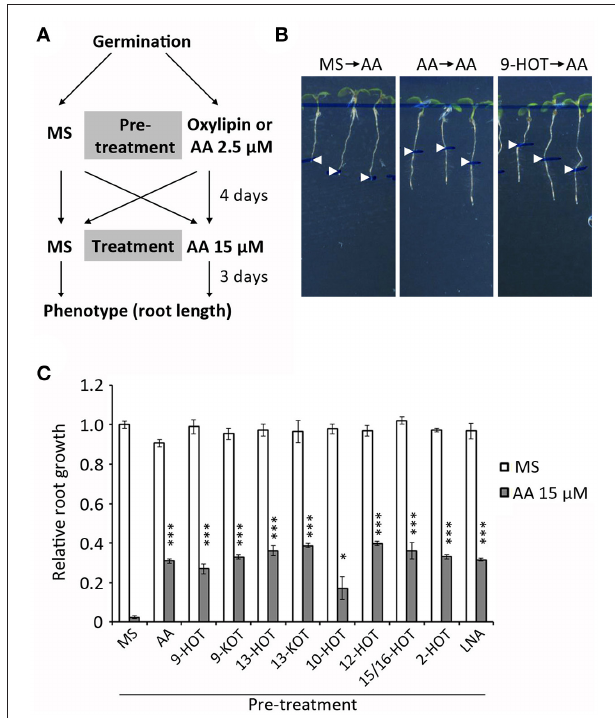
FIGURE 5 | Pretreatment with oxylipins or mild mitochondrial stress protects seedlings against severe mitochondrial damage (A) Experiment design: wild type plants were grown 4 days on MS medium with 2.5 µ M AA, 20 µ M oxylipins (9-HOT, 9-KOT, 13-HOT, 13-KOT, 10-HOT, 12-HOT, 15/16-HOT and 2-HOT) linolenic acid or MS, and then transferred to MS or 15 µ M AA to grow for 3 additional days. (B) Representative phenotype of plants grown on MS, MS with 2.5 µ M AA or 20 µ M 9-HOT and transferred to MS with 15 µ M AA. Root lengths at the moment of transfer are indicated by arrowheads (C) Root growth (relative to plants transferred from MS to MS) of wild type plants transferred from different pre-treatments to MS or MS with 15 µ M AA. Asterisks represent significant differences with control plants pre-treated with MS ( n ≥ 8, Student’s t -test, *** P < 0.001, * P < 0.05). Taken together, these results indicate that 9-HOT and 9-KOT do